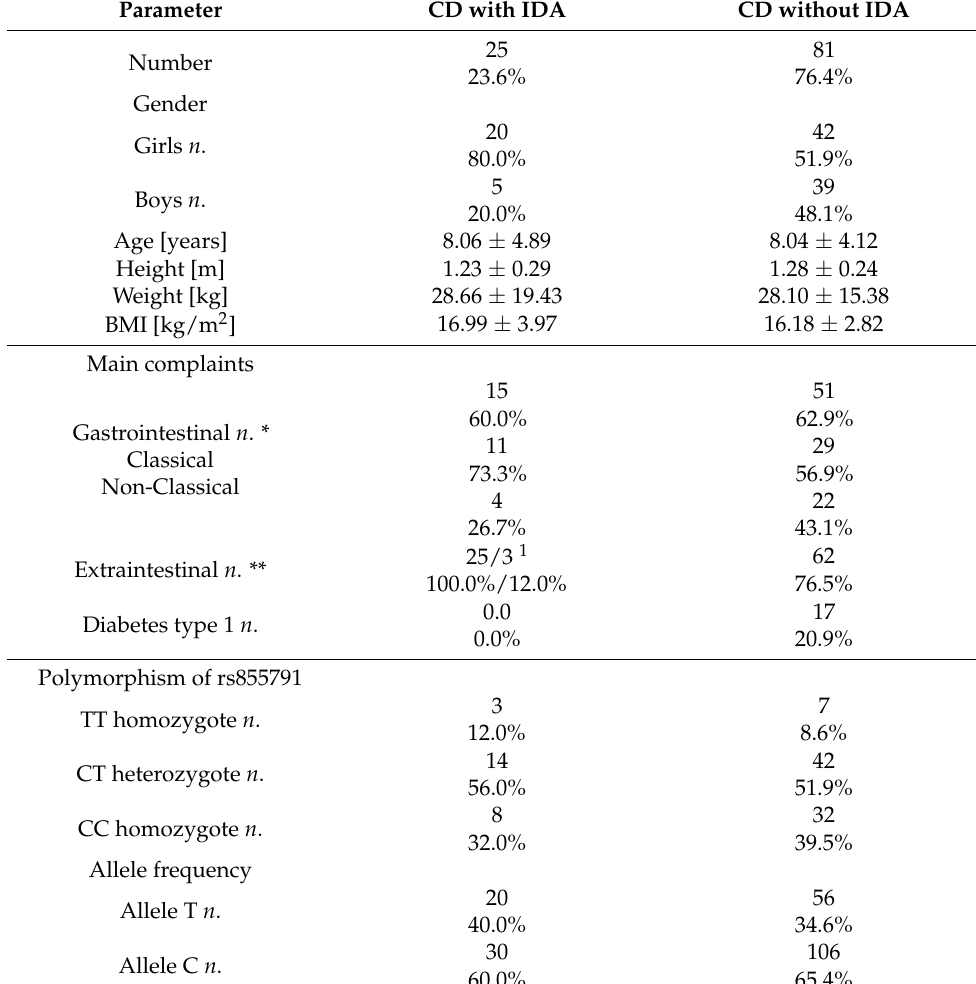
Table 1. Characteristics of CD patients with and without IDA at diagnosis and TMPRSS6 gene polymorphism